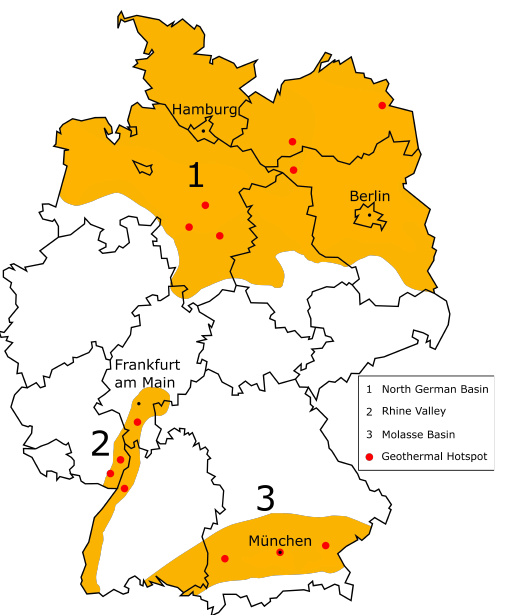
Figure 3. Map of Germany with potential geothermal